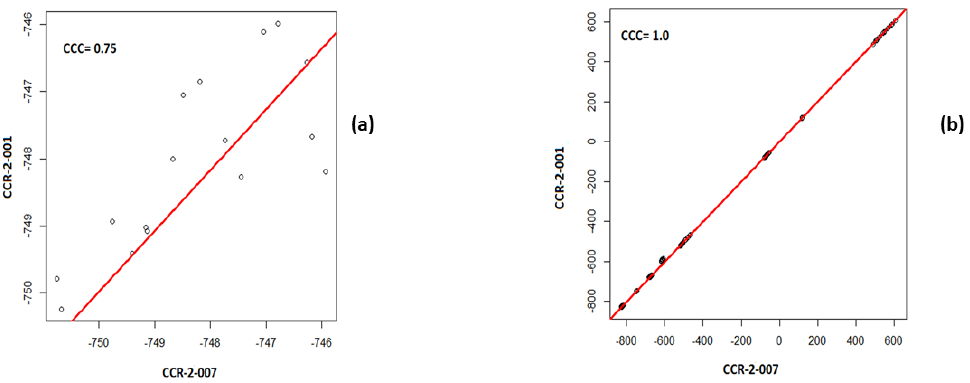
Figure 1. Pairwise plot of the first order mean values with the CCC for ( a ) a single layer of the phantom (ABS-040), ( b ) all layers of the phantom, for the scans CCR-2-001 and CCR-2-007.